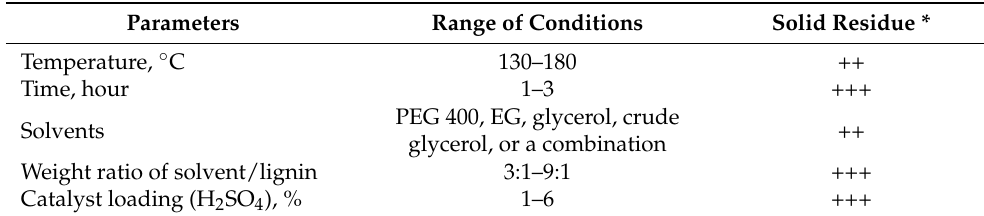
Table 5. Summary of operating conditions of acid liquefaction of lignin using H 2 SO 4 , and their effect on the formation of solid residue